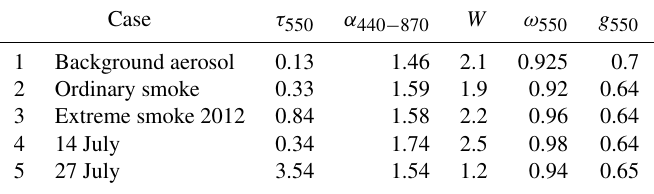
Table 5. Parameters of radiation